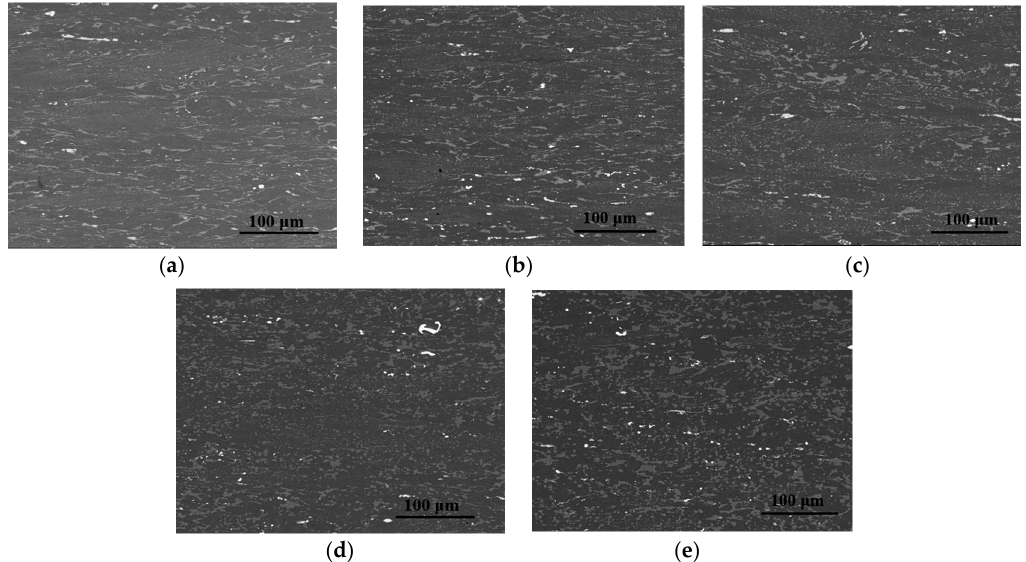
( d ) Figure 4. ( a ) X ‐ ray diffraction patterns of specimens deformed at strain rate of 0.001 s − 1 and heat treatment for 1200 s; phase map corresponds to ( b ) heat treatment at 1200 °C for 1200 s; and ( c ) deformed at 1200 °C. Microstructures of deformed specimens at the strain rate of 0.01 s − 1 and different temperatures ranging from 1000 °C to 1200 °C are shown in Figure 5. The β phase uniformly distributes in γ matrix. Elongated β phase, perpendicular to the direction of compression, is distributed in γ grain boundaries